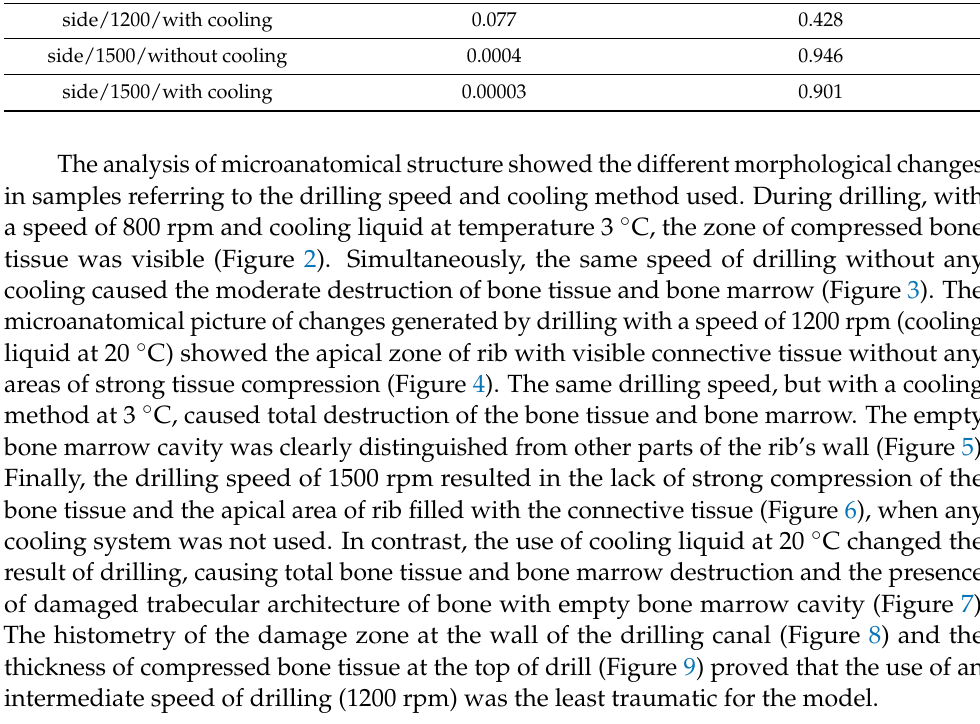
Figure 3. Rotation of 800 rpm (without cooling). Moderate destruction of the bone tissue and bone marrow. Visible debris of bone trabecular architecture and bone marrow (arrow). Figure 4. Rotation of 1200 rpm (20 °C). The apical area of rib filled with connective tissue. The lack of strong tissue compression areas caused by the drill.